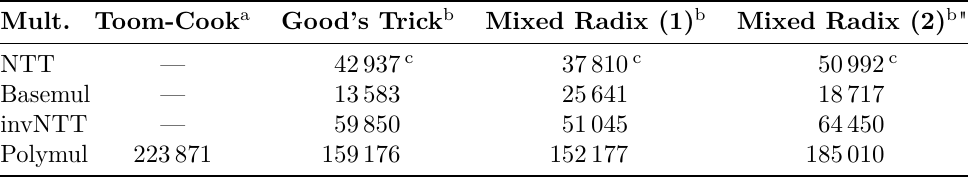
Table 5: Cycle counts for operations during polynomial multiplication.